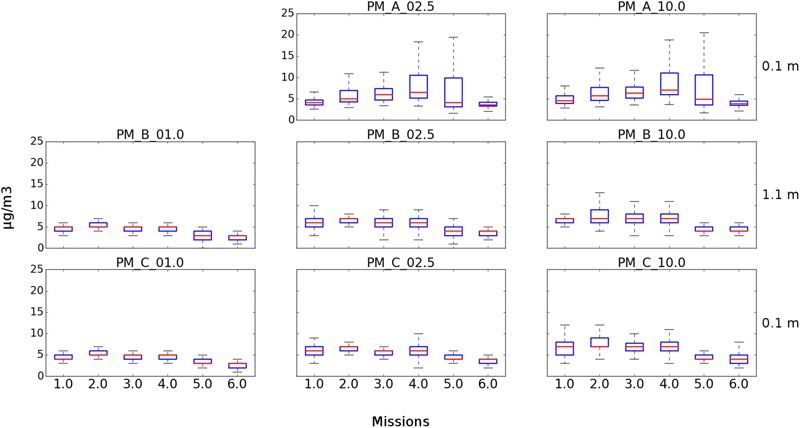
Box plots showing PM concentrations from USV missions at Claytor Lake, Dublin, VA, United States. Three of the four integrated particle sensors were operational for the six missions. (Top) Represents the SDS021 sensor at 0.1 m for PM2.5 and PM10. (Middle) Represents the PM7003 sensor at 1.1 m for PM1, PM2.5, and PM10. (Bottom) Represents the PM7003 sensor at 0.1 m for PM1, PM2.5, and PM10.